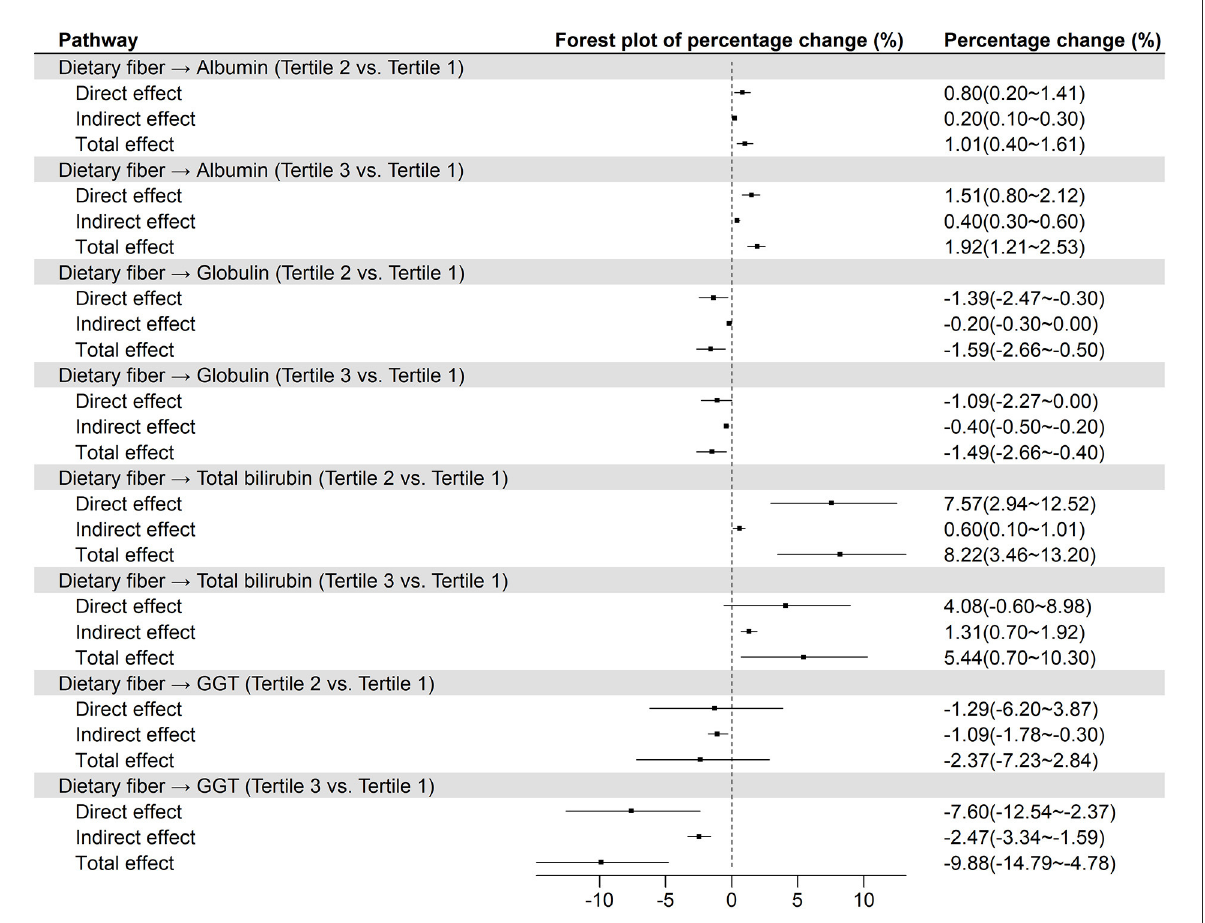
FIGURE3 The relationship between dietary fiber and liver function parameters from mediation analysis with controlling obesity as a mediator a . GGT, Gamma-glutamyl transaminase. a Model was adjusted for adjusted for age, sex, smoking, race/ethnicity, education, ratio of family income to poverty, physical activity, total energy, hypertension, and